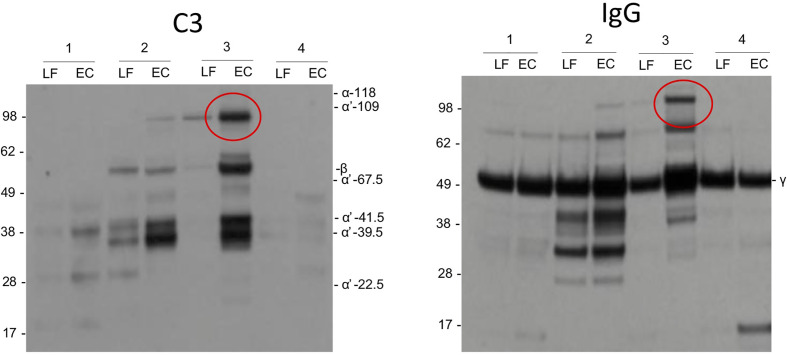
Complement activation by IgG. As evidence for complement activation by IgG we detected in some samples by Western blotting high m.w. bands (circled) that stained both for IgG heavy chain and C3. These bands may present SDS- and reduction-resistant covalent complexes between the IgG heavy chain (50 kDa) and a C3 activation fragment. The C3-IgG complexes could indicate local complex formation between IgG and C3b and thus C3 activation by the IgG antibodies.